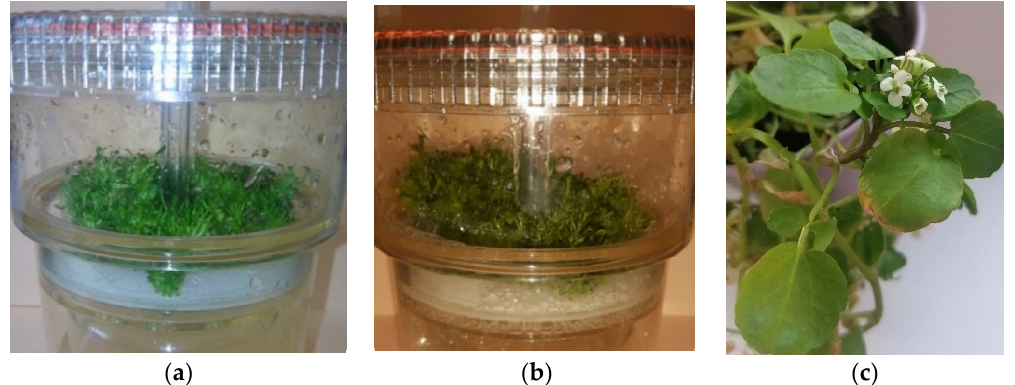
Figure 1. Microshoot cultures of N. officinale cultivated in bioreactor RITA ® TIS on MS medium containing 1 mg / L BA and 1 mg / L NAA after: 10 days of growth period ( a ); 20 days of growth period ( b ); and the herb of N. officinale ( c ).